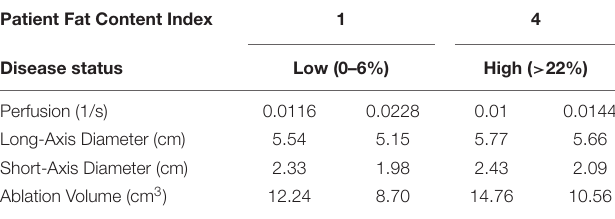
TABLE 4 | Disease status (and fat-content range) for each model and the perfusion used, and the average ± SD of the final ablation volume (cm), long distance diameter (cm), and short distance diameter (cm) in models with a